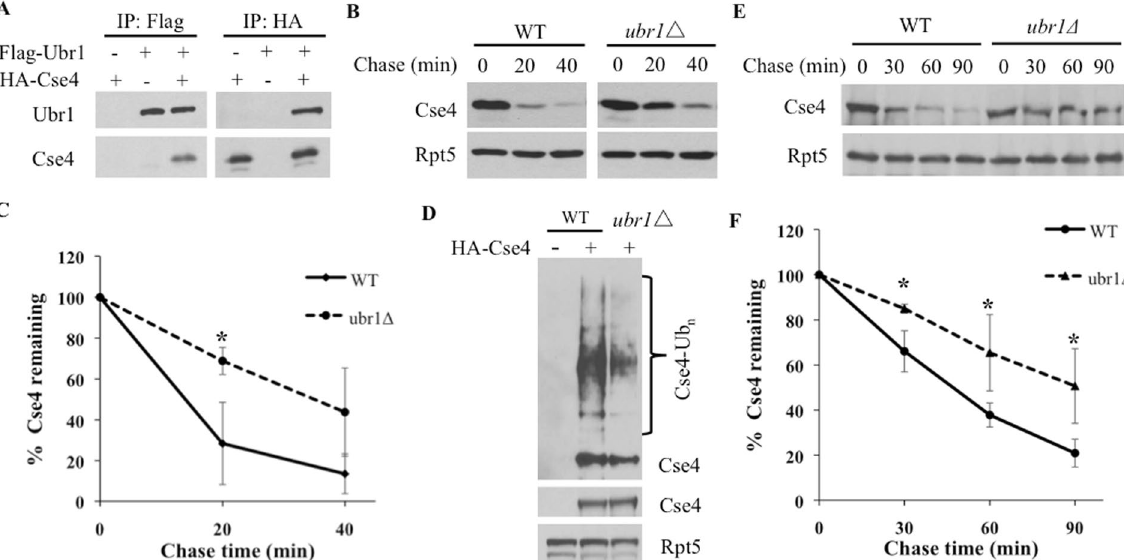
Figure 4. Ubr1 E3 regulates Cse4 turnover. ( A ) Ubr1 associates with Cse4 in vivo . A plasmid bearing HA-Cse4 or Flag-Ubr1 and/or a control vector were transformed into yeast cells. Proteins were extracted from the cells indicated and incubated with IgG beads coated with Flag or HA antibody. The samples were resolved by SDS- PAGE and visualized by western blotting using Flag or HA antibody as indicated. The identity of the bands is shown to the left of the panels. ( B , C ) Cse4 degradation in wild-type and ubr1 Δ cells was determined and quantified as above. ( D ) Reduced Cse4 ubiquitylation in ubr1 Δ cells. ( E ) Ubr1 is involved in the degradation of endogenously expressed Cse4-GFP. Expression shut-off analysis of Cse4 tagged with GFP at its normal chromosomal locus was carried out in wild-type and ubr1 Δ cells. Cse4-GFP was immunoprecipitated by a GFP antibody and then analyzed by western blotting. ( F ) Quantitation of the data in E .